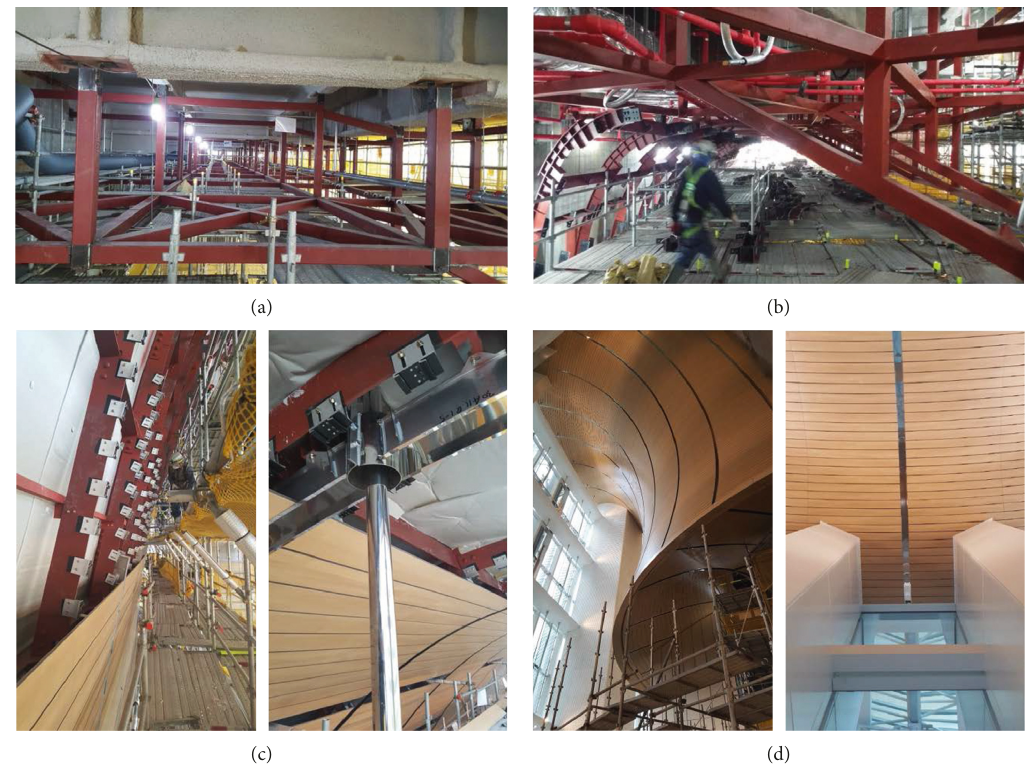
Figure 15: Site installation: (a) secondary steel structure; (b) CNC T-BAR; (c) NT panel; (d) finished